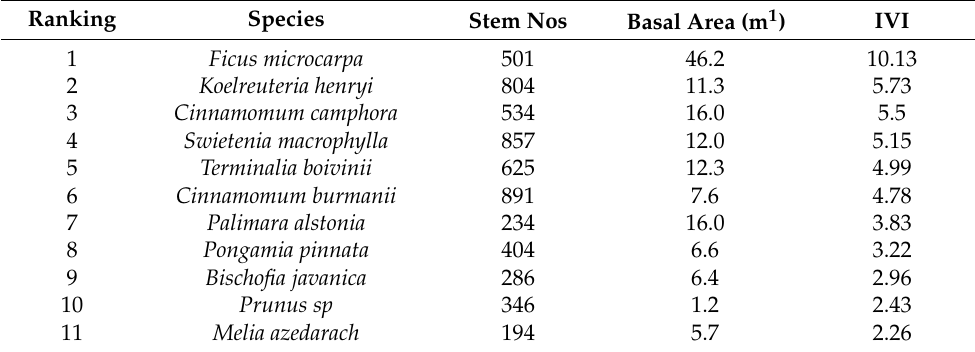
Table 5. Important Value Index tree species ranking in north of